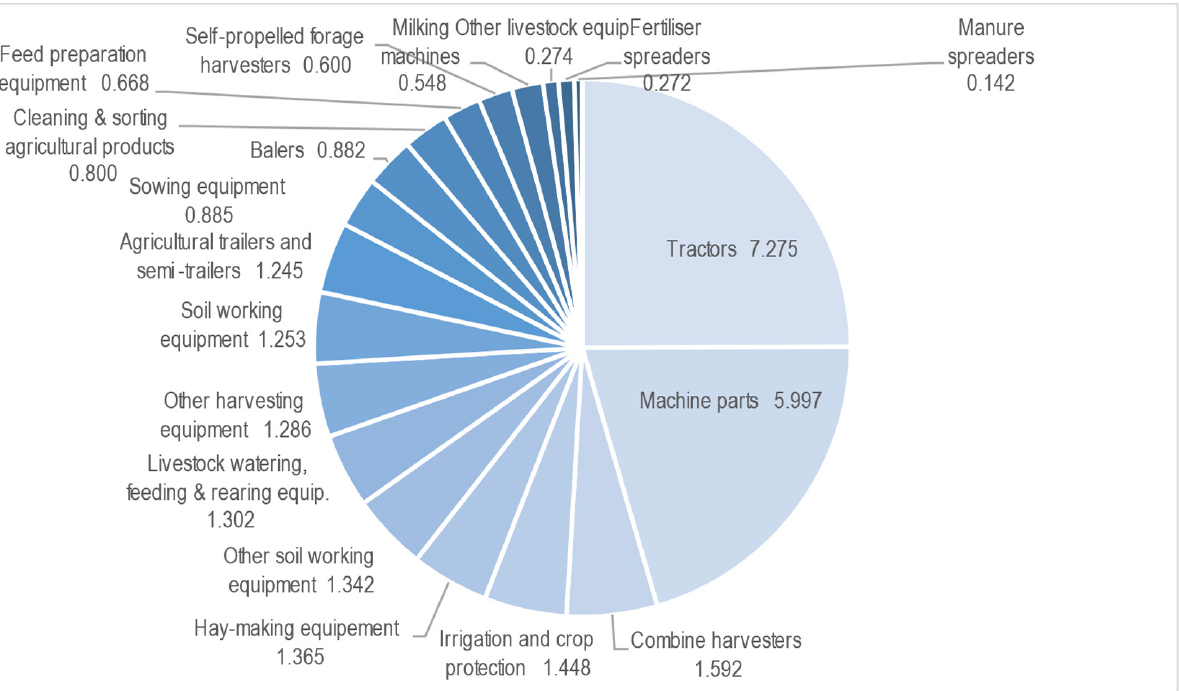
Figure 1. European (EU 27) agricultural machinery production (in thousands of million EUR) by product family in 2020.